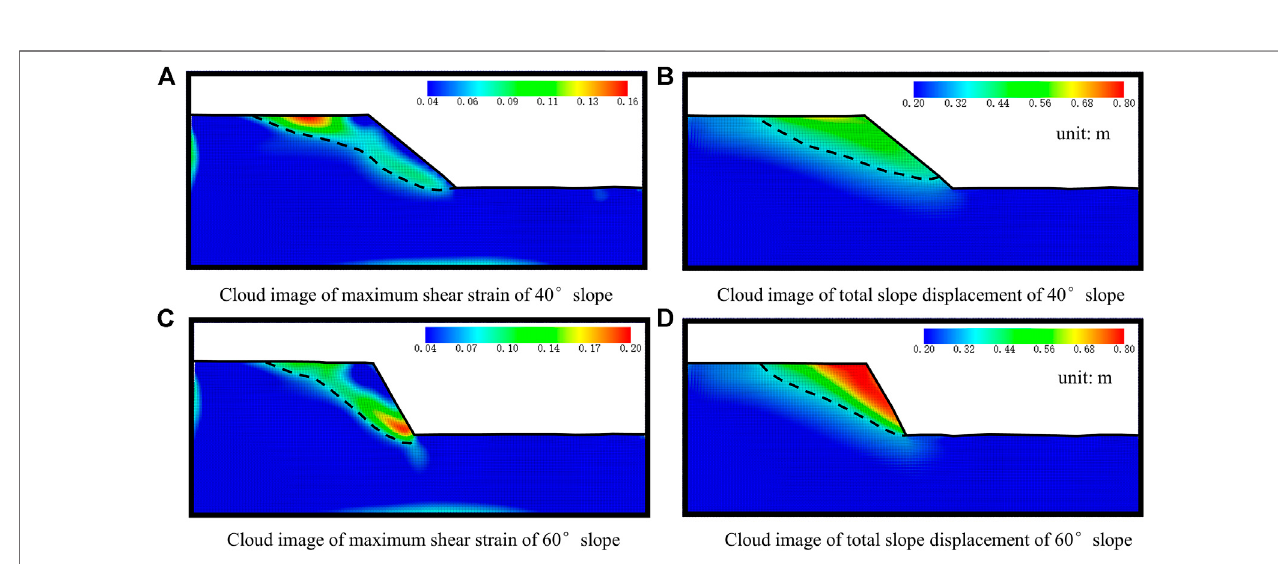
FIGURE 7 | Cloud image of shear strain and a total displacement of 40 ° and 60 ° slope with vibration.